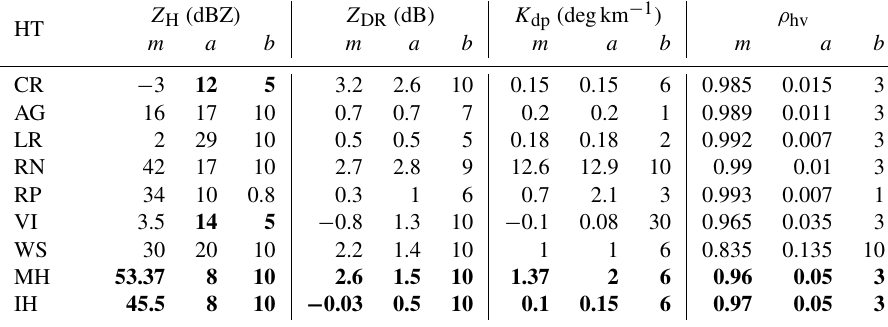
Table A2. X-band membership function parameterisation. The modified parameters are emphasized using bold font.